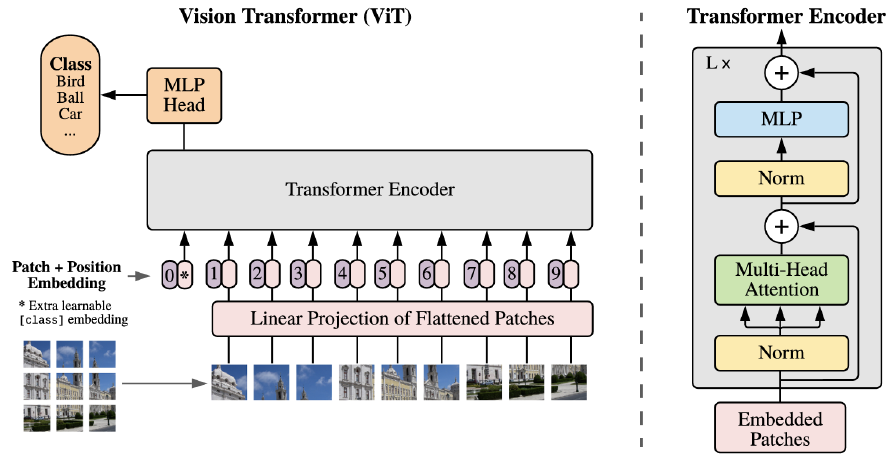
Figure 4. ViT overview [40]: ( left ) an image is split into patches, each patch is linearly embedded and fed into the Transformer Encoder; ( right ) the building blocks of the Transformer Encoder.